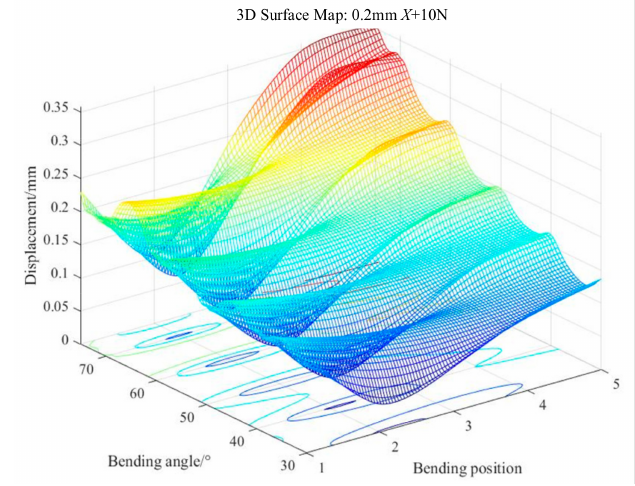
Figure 9. Displacement caused by a force of 10 N applied in the X -direction.